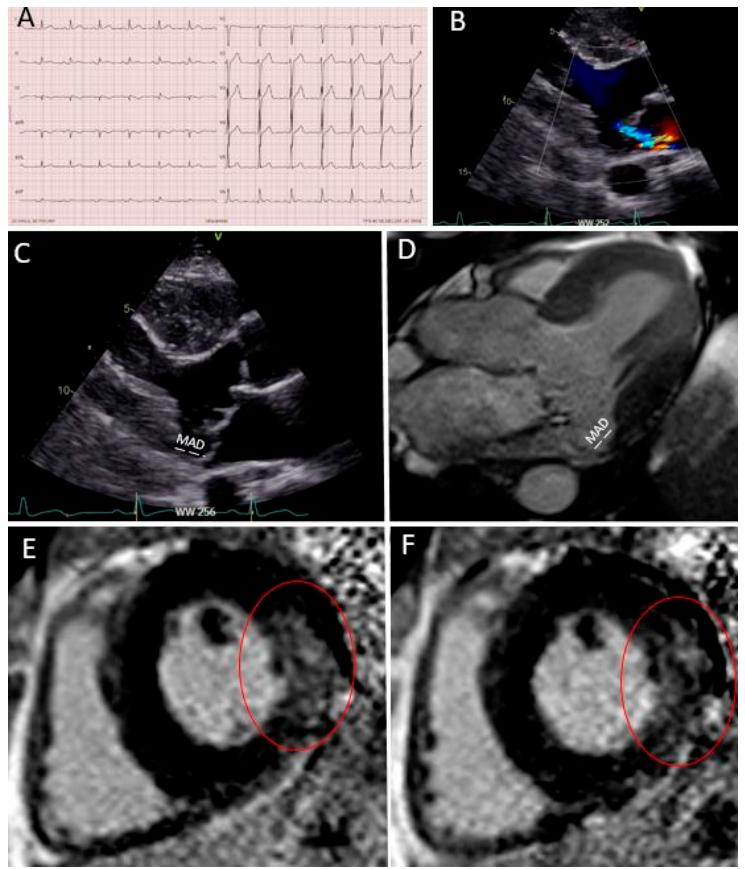
Figure 3. Case 2: Secondary prevention ICD implantation after cardiac arrest and multi-modality imaging work-up. ( A ) Patient’s ECG; ( B ) moderate mitral regurgitation during color Doppler transthoracic echocardiography; ( C ) bileaflet prolapse with MAD (in white); ( D ) MAD measured in a steady-state free precession three-chamber view during CMR; ( E , F ) a large zone of fibrosis in the basal and mid-lateral wall in LGE sequences (red circle).